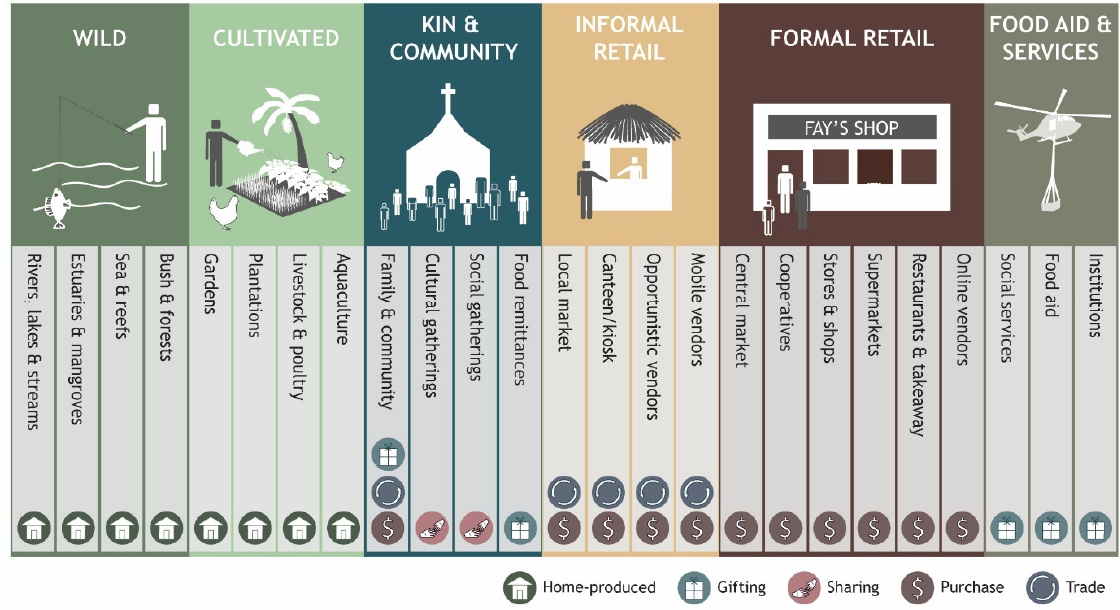
Figure 1. Conceptual typology of food environments in the Pacific Region and primary exchange mechanisms. Table 1. Definitions of food environment sub-types in the Pacific.